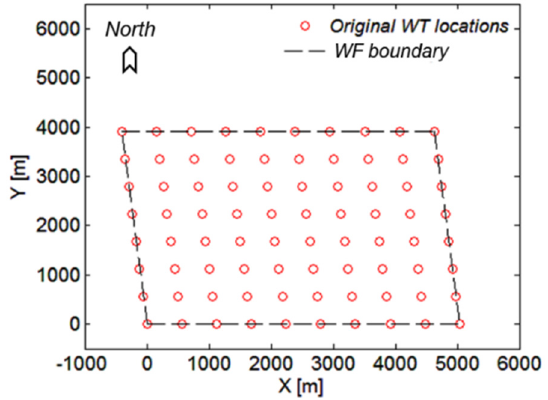
Figure 8. Original layout of the Horns Rev 1